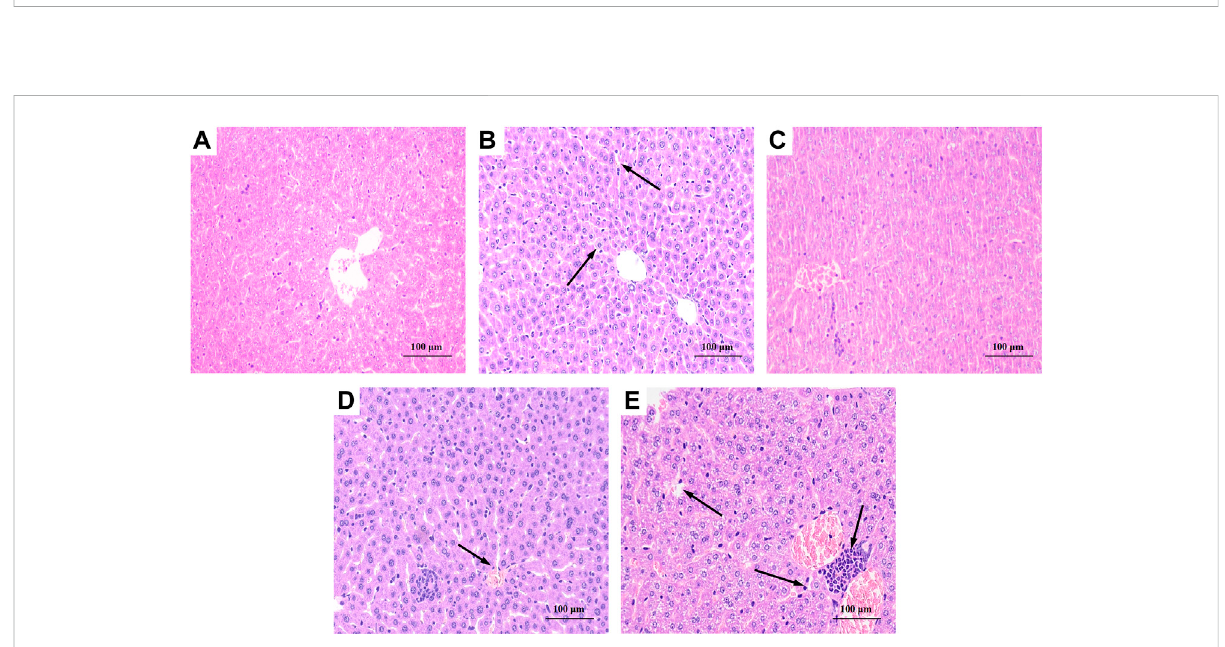
Effect of BRP-SeNPs on liver histopathological changes in CCl 4 -induced mice (×200 Magni fi cation). (A) BC, (B) MG, (C) PC, (D) H, and (E) L group. Areas of severe histopathological changes were marked by black